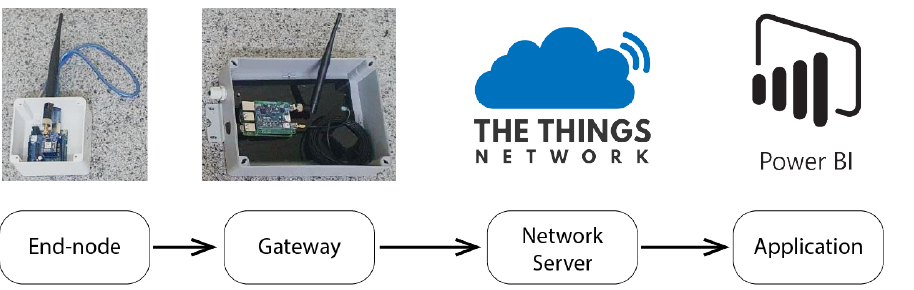
Figure 16. Gateway LoRaWAN.